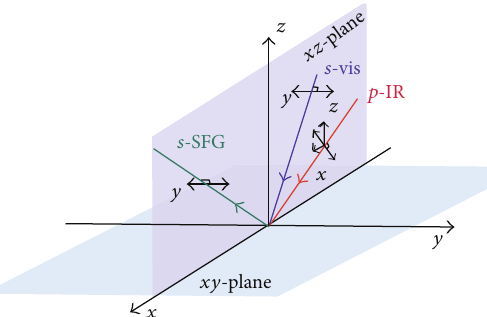
Scheme 2: The 𝑠𝑠𝑝 polarization setting in an SFG experiment: 𝑠 - polarized SFG, 𝑠 -polarized visible, and 𝑝 -polarized IR beams. The projection electric field of 𝑝 -polarized and 𝑠 -polarized light onto the laboratory